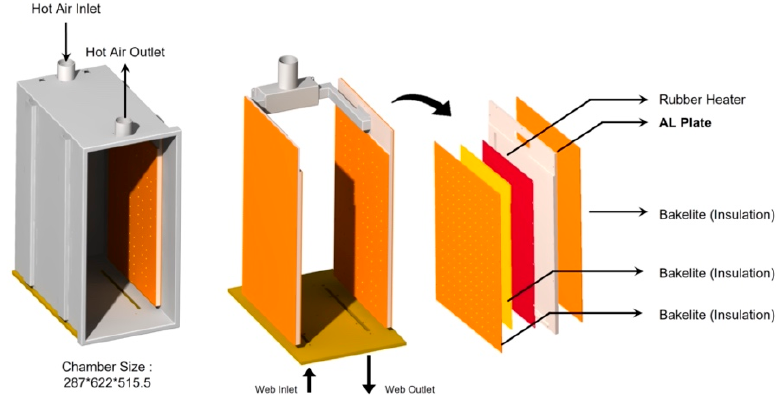
Figure 2. Detailed schematic of the dryer and its components.